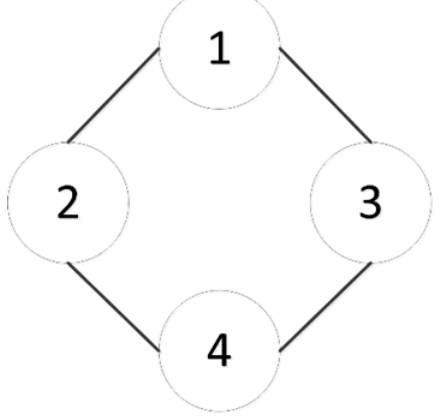
Figure 4. The topology of four LEO satellites.